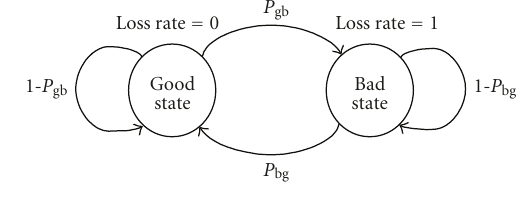
Figure 9: Gilbert